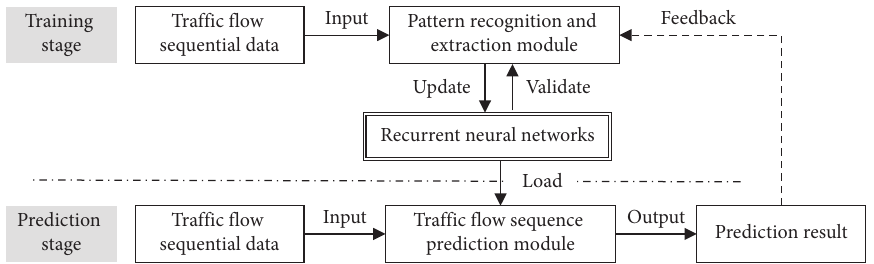
Figure 1: General framework of traffic flow time series